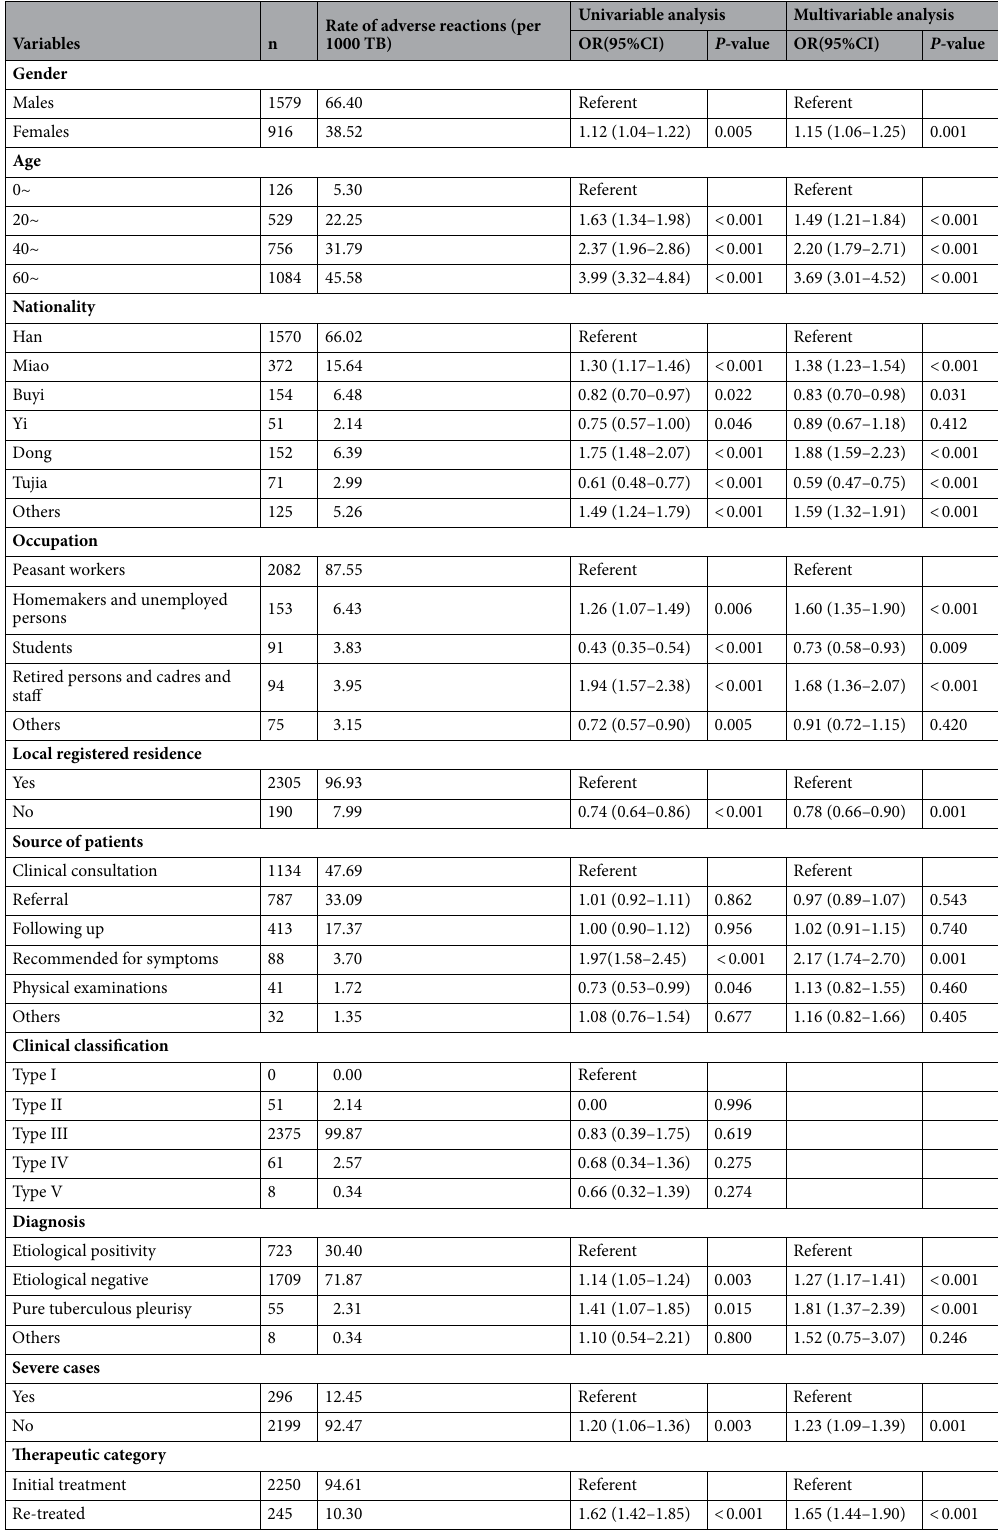
Table 1. Results of risk factors analysis of adverse reactions in TB